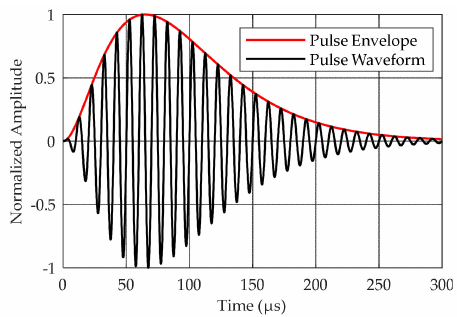
Figure 1. Reference pulse of Loran-C